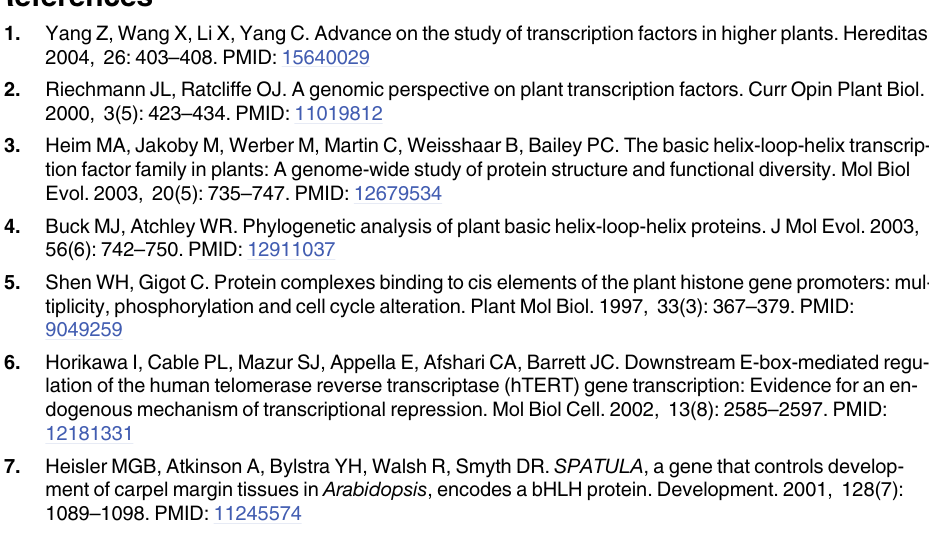
p : Polymorphic primers.